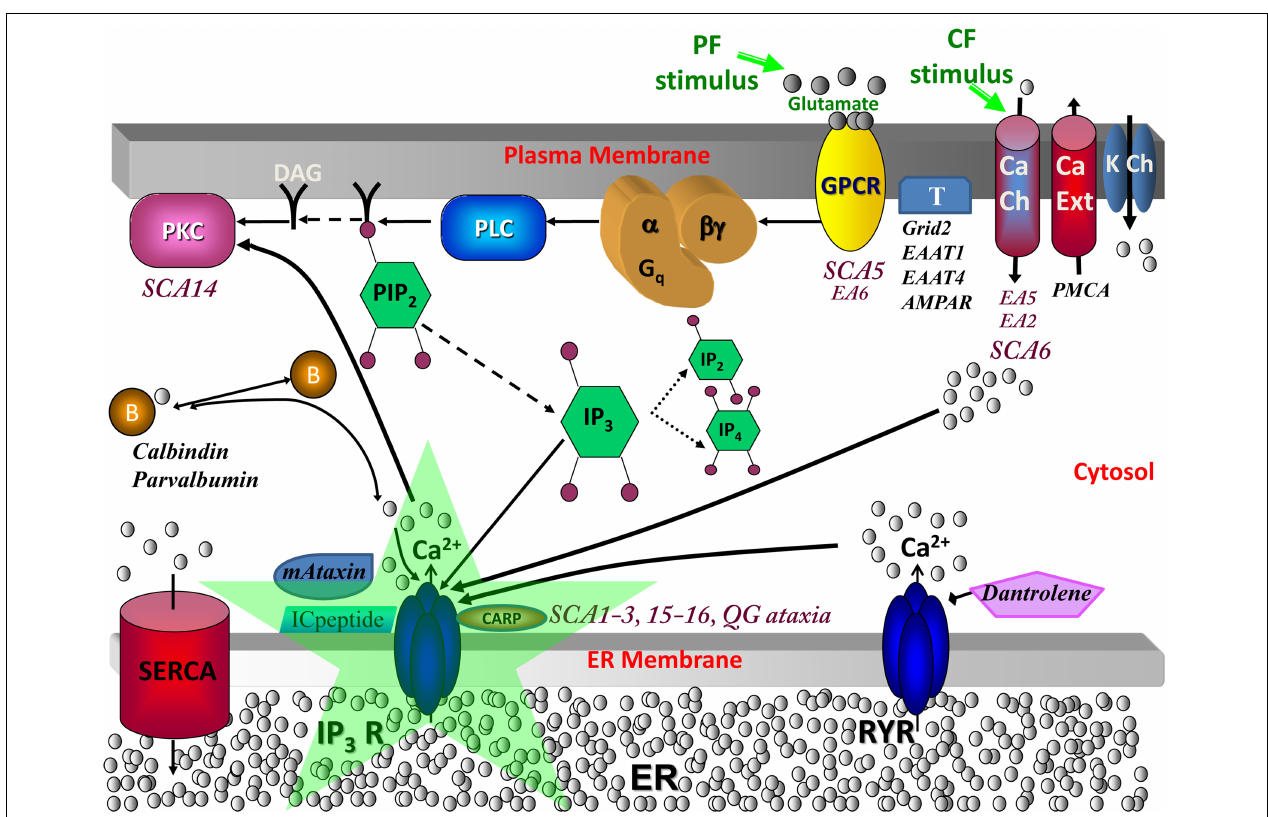
FIGURE 1 | Calcium signaling in cerebellar Purkinje neuron spiny dendrites with various molecules involved in spinocerebellar ataxias. When a parallel fiber (PF) stimulates a distal dendrite of the Purkinje neuron, the neurotransmitter glutamate is released and binds its receptor, metabotropic glutamate receptor (mGluR; from the group C family of G protein-coupled receptors, GPCR), on the plasma membrane of the Purkinje dendrite (Finch and Augustine, 1998; Takechi et al., 1998). This leads to the activation of phospholipase C (PLC), a hydrolyzing enzyme that cleaves PIP2 in the plasma membrane to produce diacylglycerol (DAG) and IP3 (Cohen, 2003). DAG stays in the membrane, where it can activate cytosolic molecules close to the membrane, such as PKC (Nishizuka, 1984). IP3 diffuses away from the reaction site (the plasma membrane) to its receptor on the endoplasmic reticulum (ER) (Berridge et al., 2000). IP3 is also free to diffuse out of the spine head, through